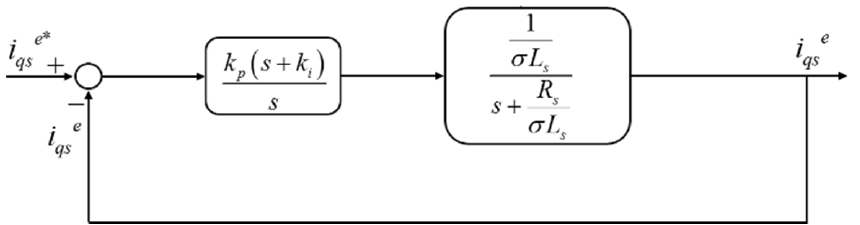
Figure 7. Simplified block diagram of q − axis current controller. The obtained closed-loop transfer function stability is shown in Figure 8. As observed, there were two poles and one zero on the left-hand side of the pole-zero map. This confirmed that the controller fulfilled the stability criterion, which meant that it was in a stable